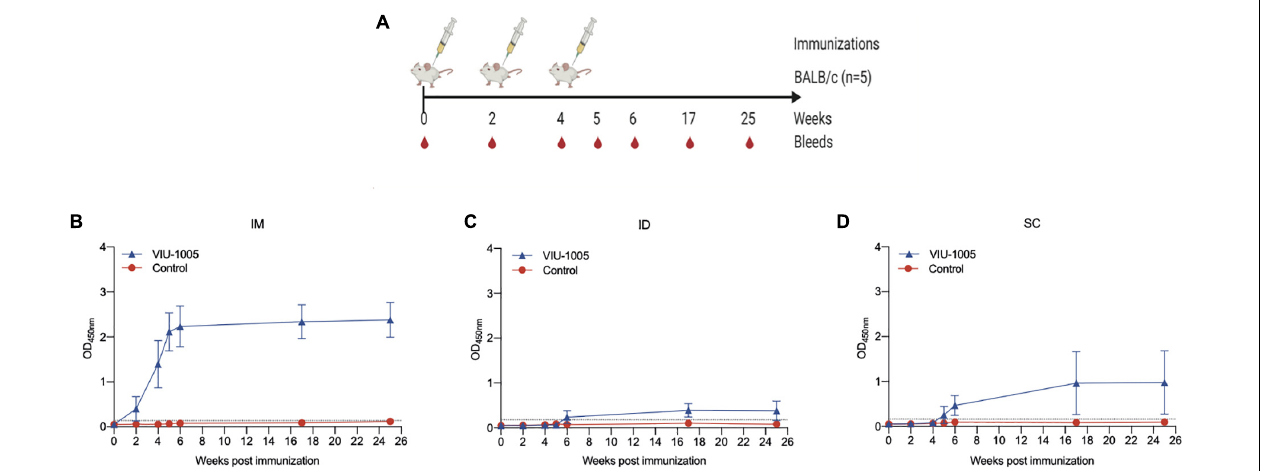
FIGURE 3 | Long-term IgG response in mice immunized with different routes. (A) BALB/c mice were immunized via different routes using 3 doses (100 µ g each) at 2-week intervals using either VIU-1005 or control plasmid. The timeline shows the bleeding and immunization regimen. OD values of S1-specific binding total IgG at a 1:100 dilution from each mouse immunized via (B) intramuscular, (C) intradermal, or (D) subcutaneous routes were determined by ELISA at 2, 4, 5, 6, 17, and 25 weeks post first immunization on day 0. Data are shown as the mean ± SD for each group from one experiment ( n =